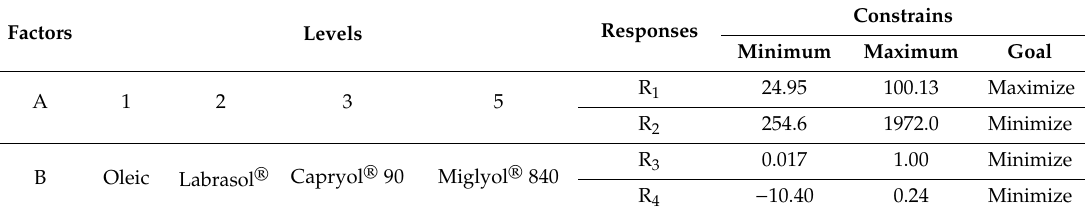
Table 1. Levels of dependent and independent variables used in the factorial